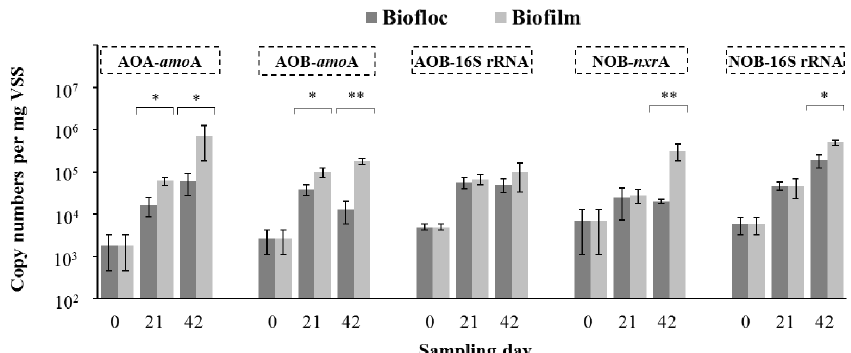
Figure 4. Abundance comparison of nitrifying microbial communities based on qPCR of 16S rRNA and functional genes between biofloc and biofilm from the biofloc-RAS for shrimp intensive culture in a 70-day trial (mean ± S.D., N = 3; * p < 0.05; ** p < 0.01). AOA- amo A represents ammonia-oxidizing archaea based on the archaeal amo A gene, AOB- amo A represents ammonia-oxidizing bacteria based on bacterial amo A gene, AOB-16S rRNA represents ammonia-oxidizing bacteria based on 16S rRNA gene, NOB- nxr A represents nitrite-oxidizing bacteria based on nxr A gene, NOB-16S rRNA represents nitrite-oxidizing bacteria based on 16S rRNA gene.